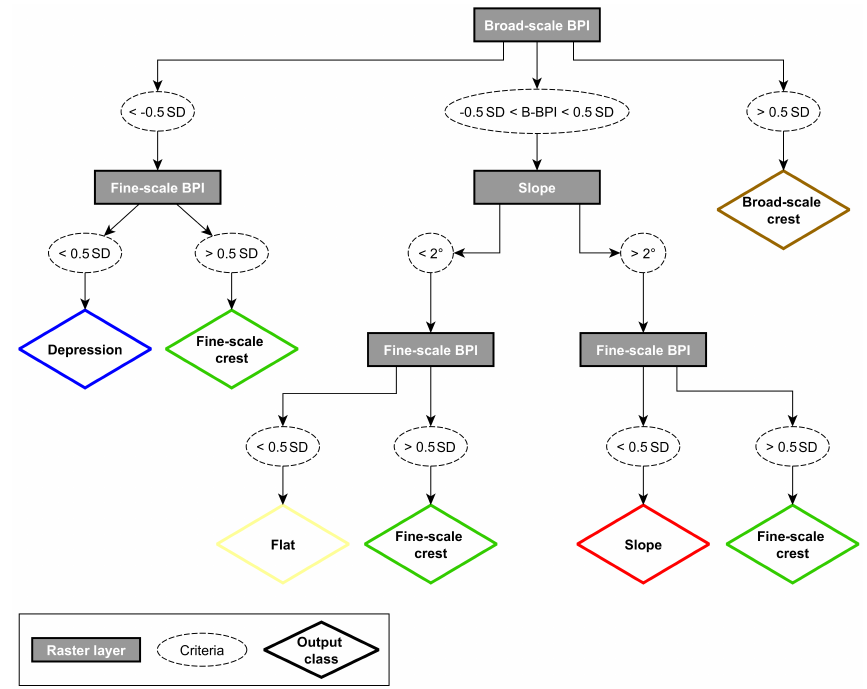
Figure 4. Classification decision tree, showing how the geomorphometric classification was conducted in the benthic terrain model tool.